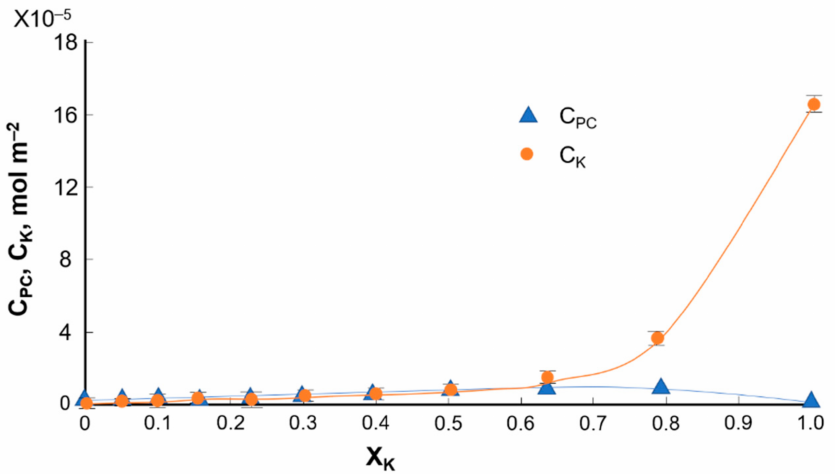
Figure 8. Dependence of the total surface concentration of PC (C PC) and K (C K )) vs. the mole fraction of